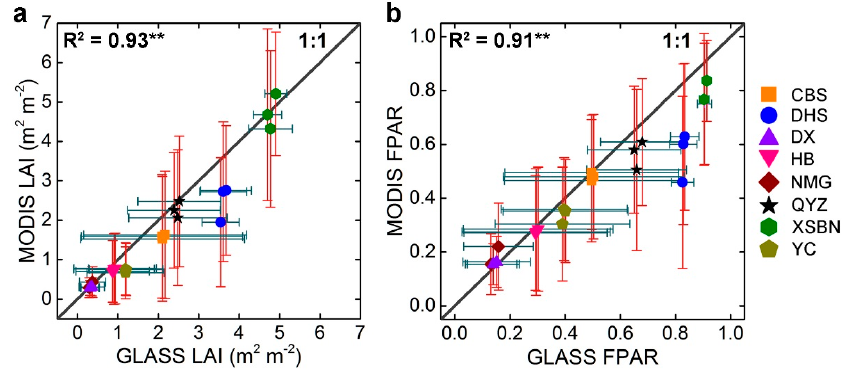
Figure 10. Comparison of the average ( a ) LAI and ( b ) FPAR from the MODIS datasets and the GLASS LAI products. Significance levels: ** p < 0.01. Table 5. Comparison of the LAI and FPAR derived from the GLASS LAI datasets with those from the MODIS products for various biomes.